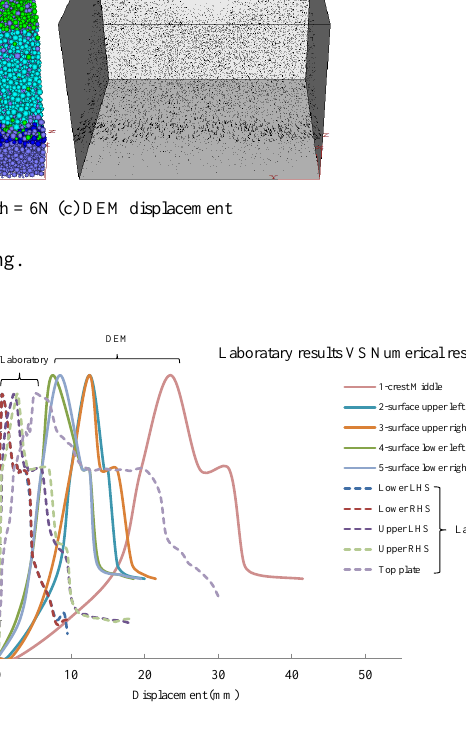
and DEM modeling.